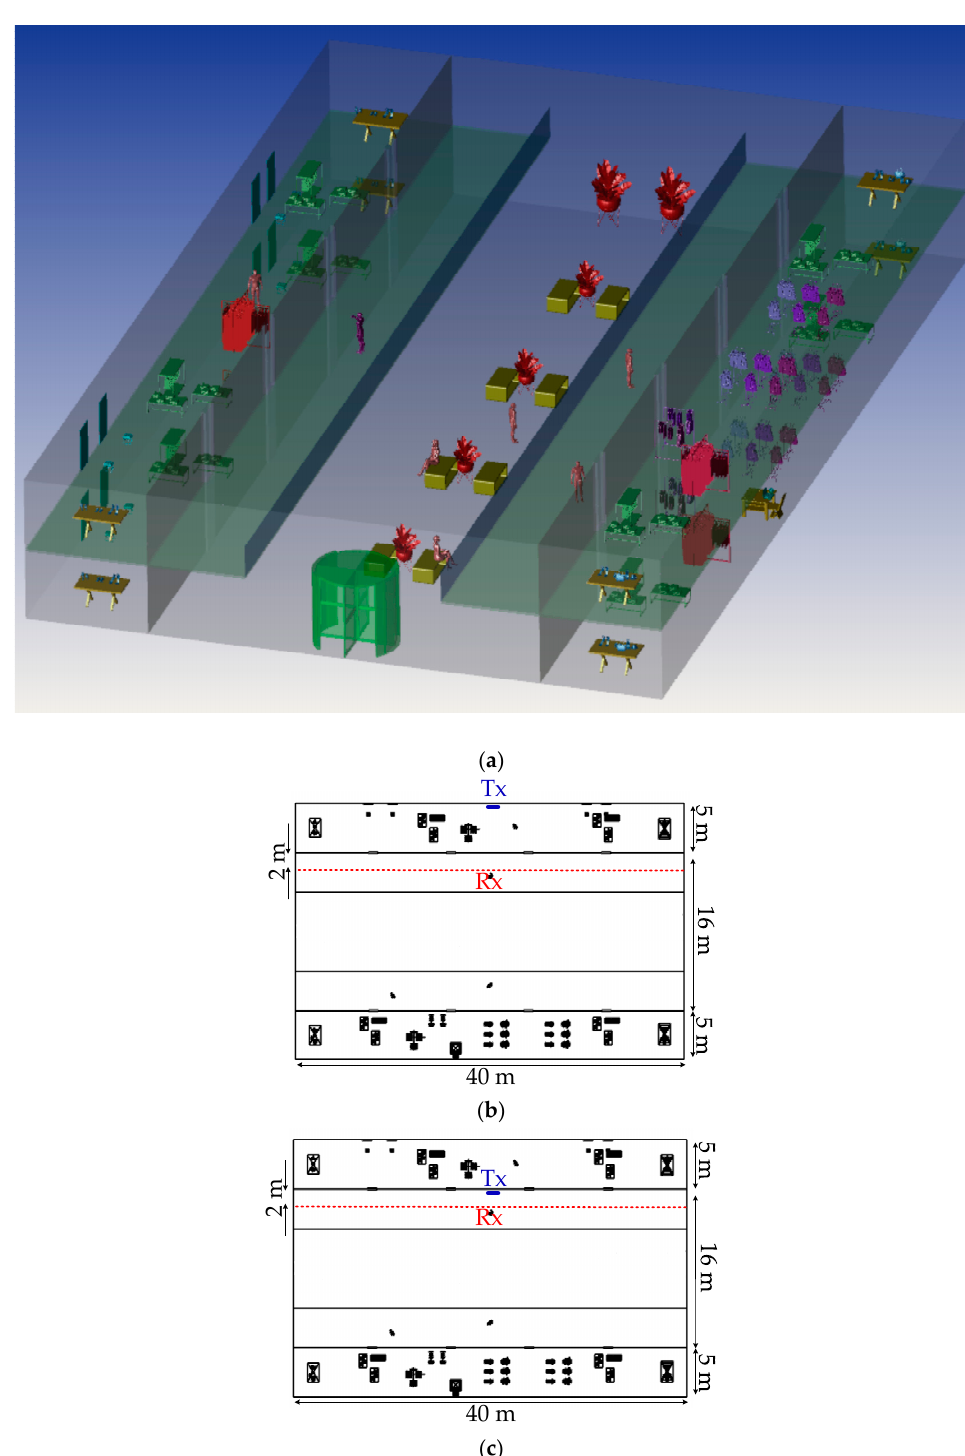
Figure 5. ( a ) The three-dimensional semi-open corridor environment and proposed scenarios which show the location of Rx and Tx, ( b ) where Tx is located on inner shop wall behind window (case1), and ( c ) on wall or shop window inside the corridor (case2).